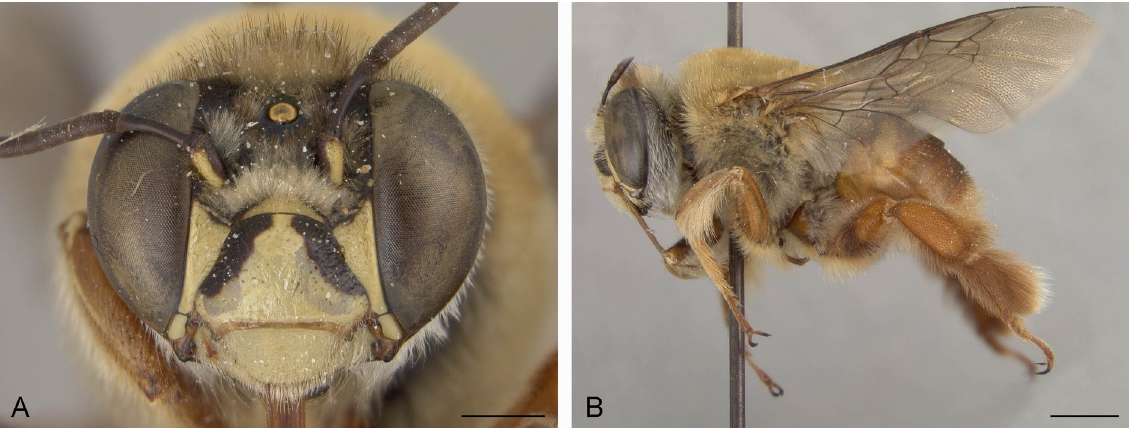
Fig. 6. Centris inermis pallidifrons Cockerell, 1949, holotype, ♂ (NMNH; USNM ENT 00534207). A . Frontal view. B . Habitus, lateral view. Scale bars: A = 1 mm; B = 2